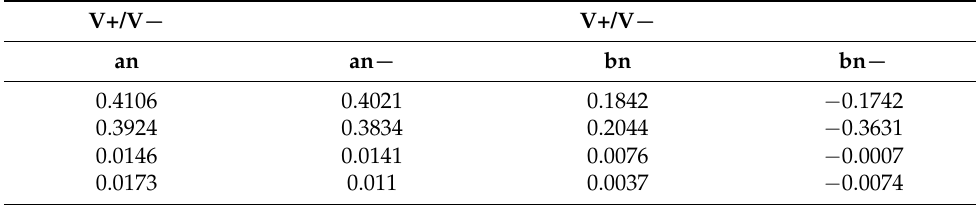
Figure 20. Maps of speed vs. Friction of each motor in left arm. Table 5. Table of friction coefficients for each motor on the left